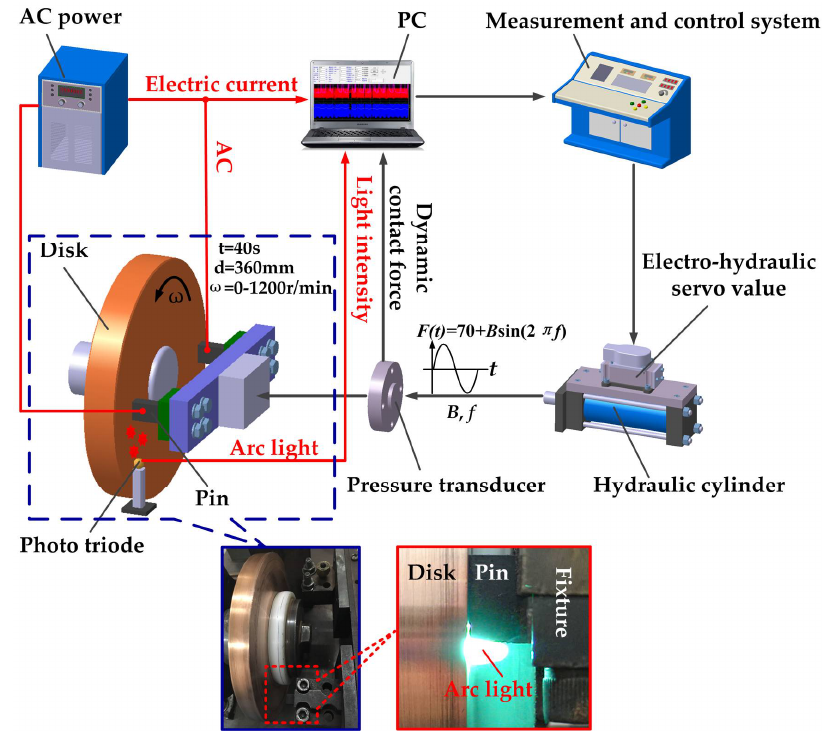
Figure 2. Schematic diagram of the test rig.